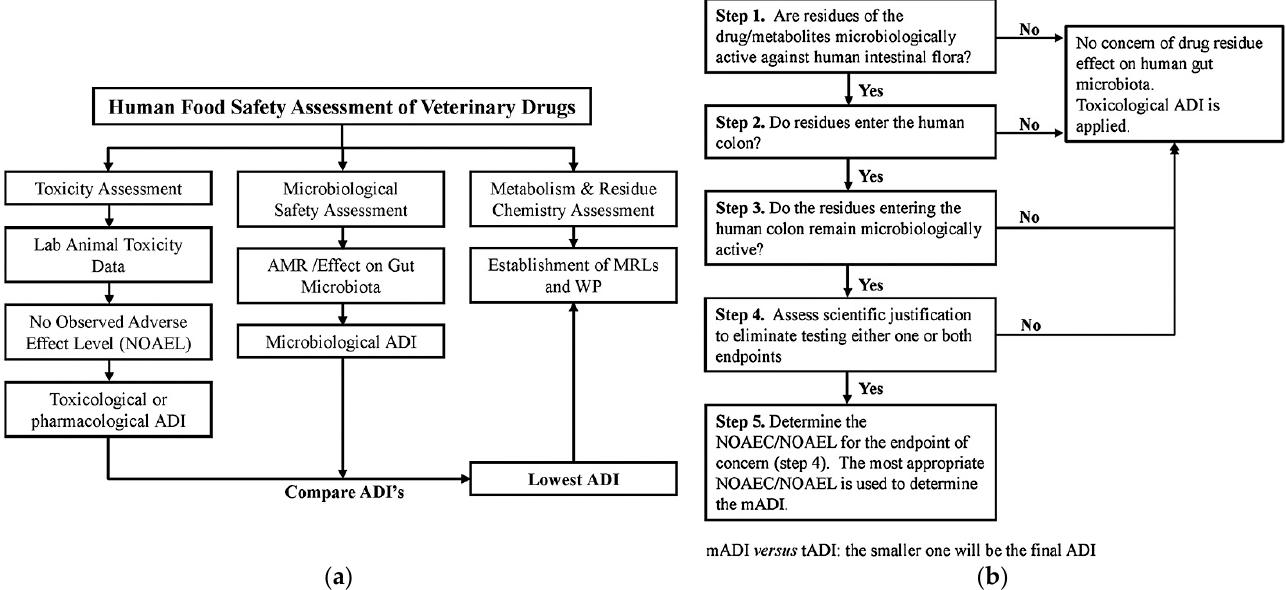
Figure 1. Food safety assessment of veterinary drugs ( a ). Stepwise determination of the need for a mADI (microbial acceptable daily intake) ( b ). ADI: acceptable daily intake; AMR: antimicrobial resistance; mADI: microbial ADI; MRL: maximum residue level; NOAEC: no observed adverse effect concentration; tADI: toxicological ADI; reproduced by permission from John Wiley and Sons [126].